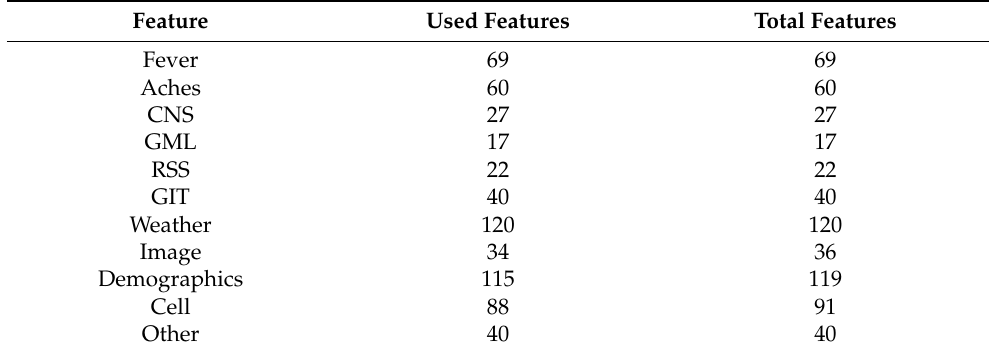
Table 8. Frequency of total features and used features.